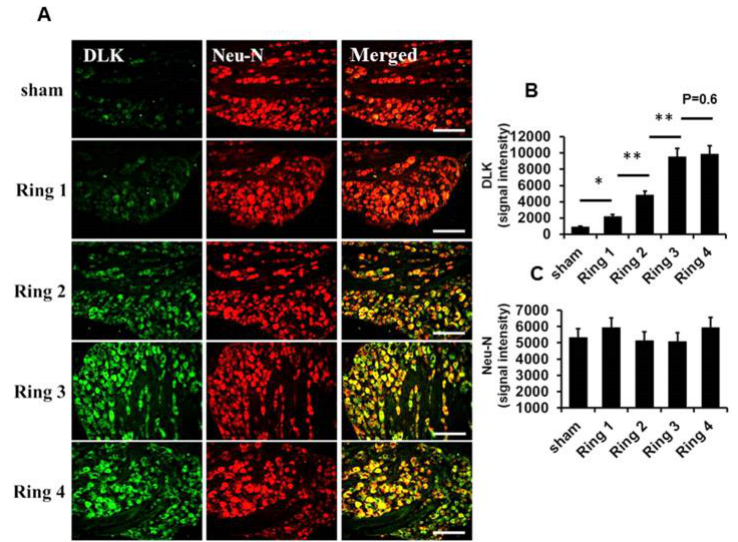
Figure 2. Depiction of DLK expression over the dorsal root ganglia cells subjected to the escalating numbers of ligature rings from one to four in animals four weeks after CCI. ( A ) Illustration of DLK expression over the dorsal root ganglion cells co-localized with Neu-N related to the escalated number of nerve ligations from one to four rings. ( B , C ) Quantitative analysis for expression level of DLK and Neu-N in the dorsal root ganglia cells. Bar length= 200 μ m; * p < 0.05; ** p < 0.01.